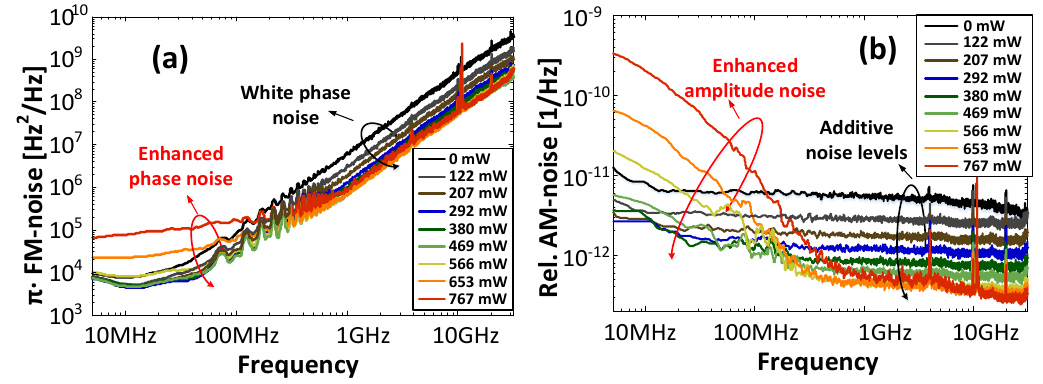
Figure 3. ( a ) Measured frequency noise and ( b ) relative amplitude noise power spectrum density for different pump powers. For all selected cases, the launched power = 5 dBm, fiber length = 200 km.